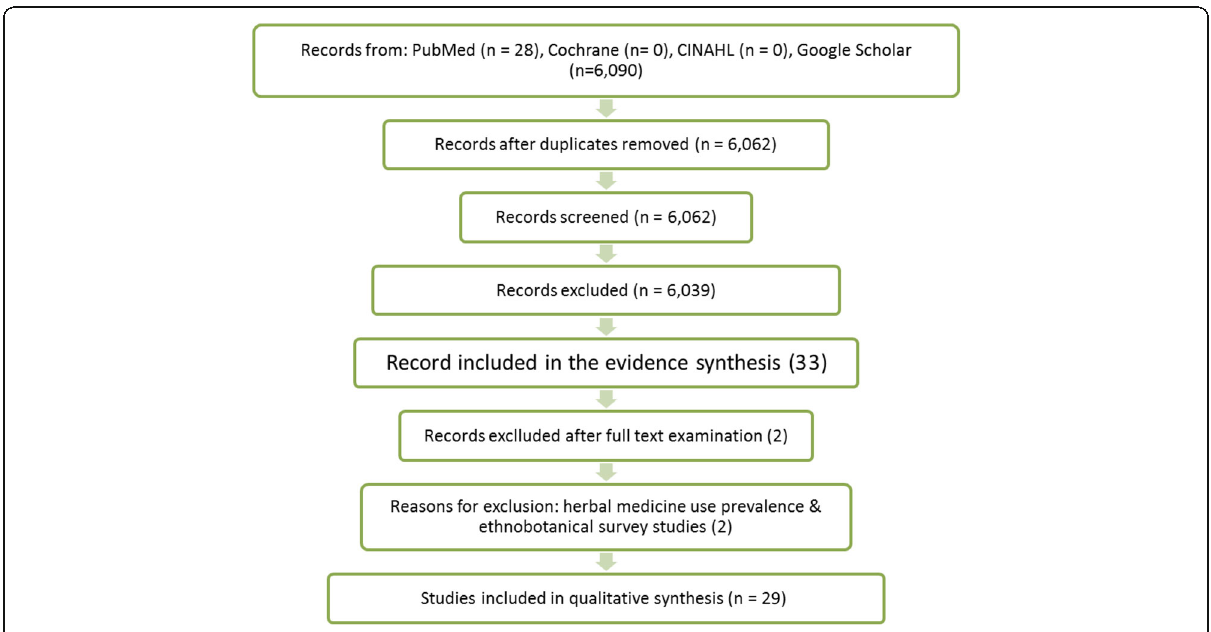
Fig. 1 Flow diagram showing, screened, excluded and included